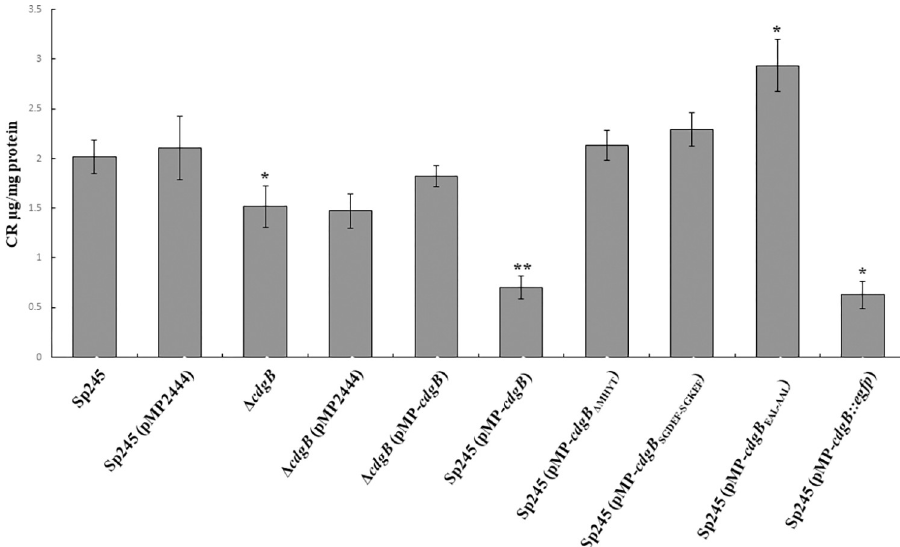
Fig 5. CdgB alters EPS accumulation in A . baldaniorum Sp245. Graph representing the mean and standard deviation of EPS quantification after 5 days of growth in statical conditions at 30˚C. Data represent results of three independent experiments with three biological replicates. Significant differences relative to WT (P < 0.05) are indicated by “ � ”and to + cdgB (P < 0.005) by “ �� ” according to Student´s t-test.